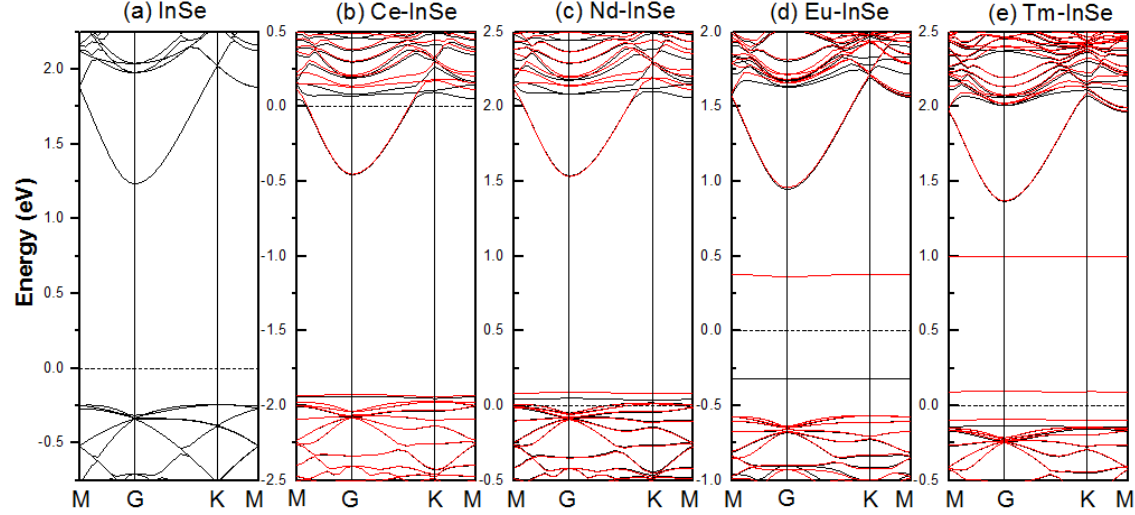
Figure 3. Band structures of the ( a ) pristine InSe monolayer and ( b ) Ce, ( c ) Nd, ( d ) Eu, and ( e ) Tm doped systems. The Fermi level is set to be zero. The black and red lines denote the spin − up and spin − down bands, respectively.